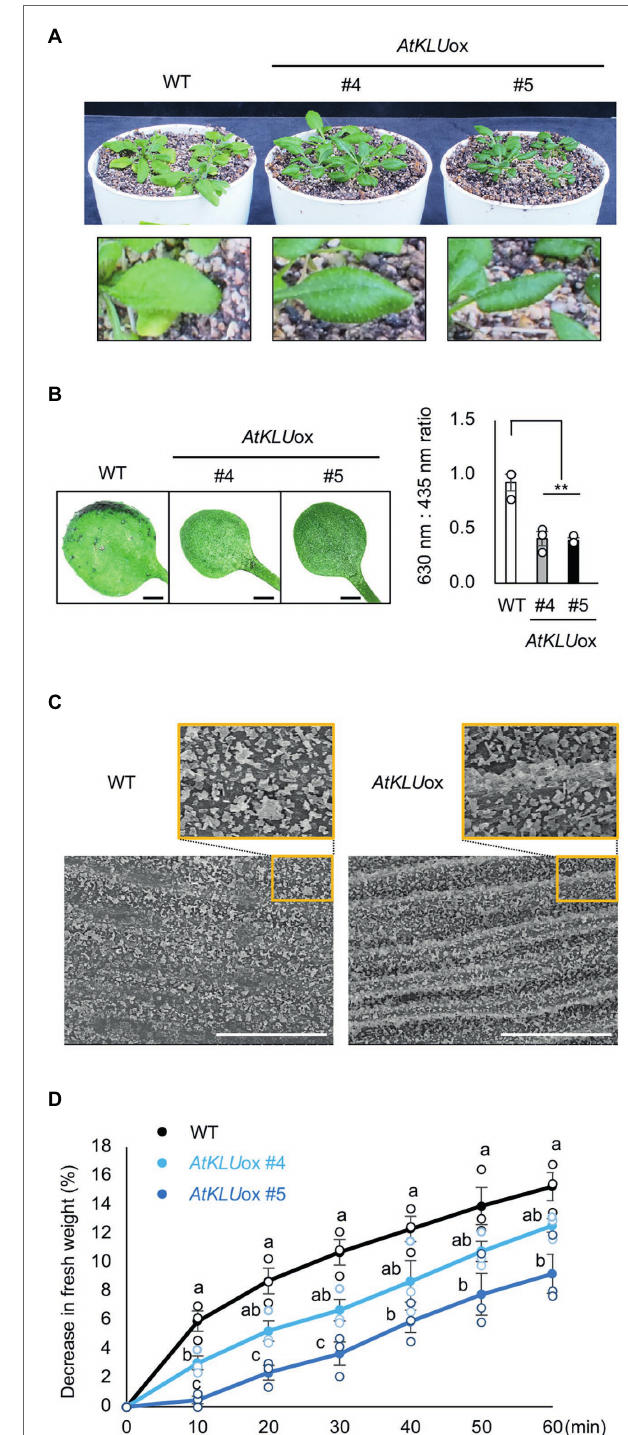
FIGURE 4 | Epidermal cuticular wax of AtKLU ox plants. (A) Four-week-old WT and AtKLU ox plants grown in soil under normal conditions. Lower panel: Magnified view of their leaves. (B) Toluidine blue (TB) test. Left panel: Two- week-old WT and AtKLU ox plants stained with TB. Right panel: TB extract was examined spectrophotometrically, and the amount of TB was determined by the absorbance at 630 nm (A630). The major peak of absorbance due to